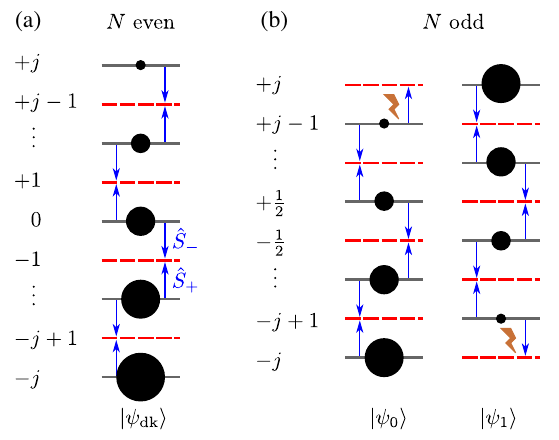
FIG. 3. Properties of the steady state of Eq. (2) for N ¼ 200 vs FIG. 2. Sketch of the steady state for (a) even N and (b) odd N . N ¼ 201 spins. For even N , the Wineland parameter (solid blue The size of the black circles represents the population of a level line) converges to a Heisenberg-limited scaling (dash-dotted j j; m i . For even N , a pure dark state exists for any squeezing ˆ Σ black line) in the limit r → ∞ . For odd N , the Wineland parameter r because the jump operator leads to destructive parameter (dashed blue line) diverges if e 2 r ≫ N and its purity interference between adjacent levels (blue arrows) such that every (dash-dotted red line) approaches 1 = 3 . Inset: minimum Wineland second level is unoccupied (dashed red lines). For odd N and parameter for even N (crosses) and odd N (dots) obtained at an large r , the interference condition cannot be satisfied for all levels optimal squeezing strength r . The squeezed spin component is (brown flashes) and the steady state is mixed. The two pure-state opt ˆ S contributions with largest statistical weight are sketched here. always y